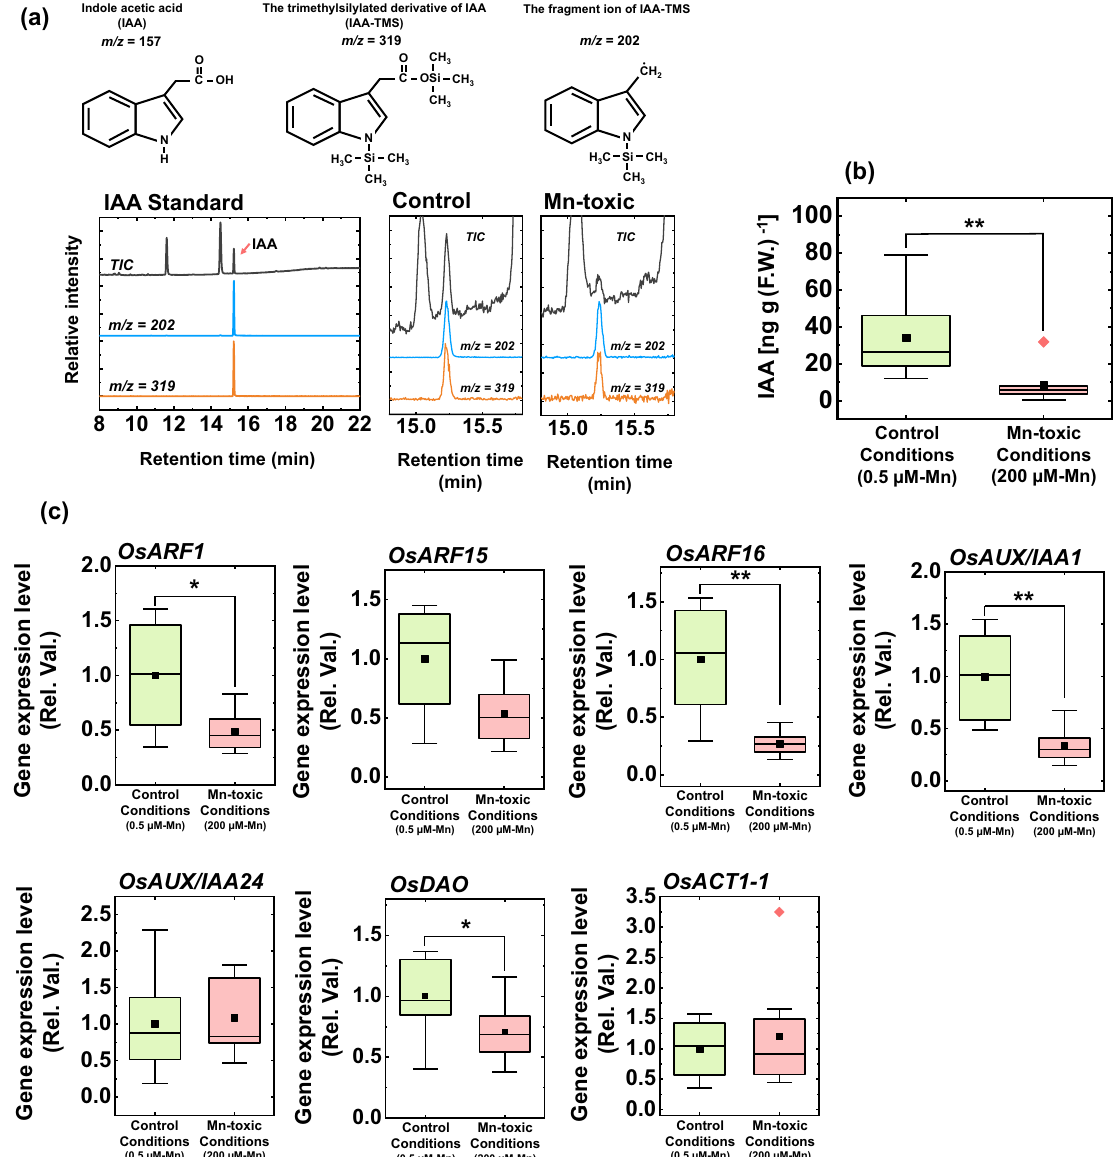
Figure 8. Leaf indole acetic acid (IAA) concentration and gene expression analysis relating to IAA and stomata development. ( a ) The result of GC–MS analysis targeting IAA, together with the chemical structures of IAA and its derivatives. The total ion chromatography (TIC) and chromatographs of m / z = 202 and m / z = 319 in the standard IAA solution and the leaf extract from plants under control and Mn-toxic conditions are shown. The retention time of the silylated IAA was 15.2 min. ( b ) The IAA concentrations in the leaf blade (n = 8). ( c ) The results of gene expression analysis involving IAA-responsive gene and stomatal patterning (n = 8). All data were obtained from independent biological replicates according to the indicated numbers. The quantified results were normalized to OsATC1-2 expression basis. Asterisks show significant differences between the control and Mn-toxic conditions (* p < 0.05, ** p < 0.01, Kruskal–Wallis